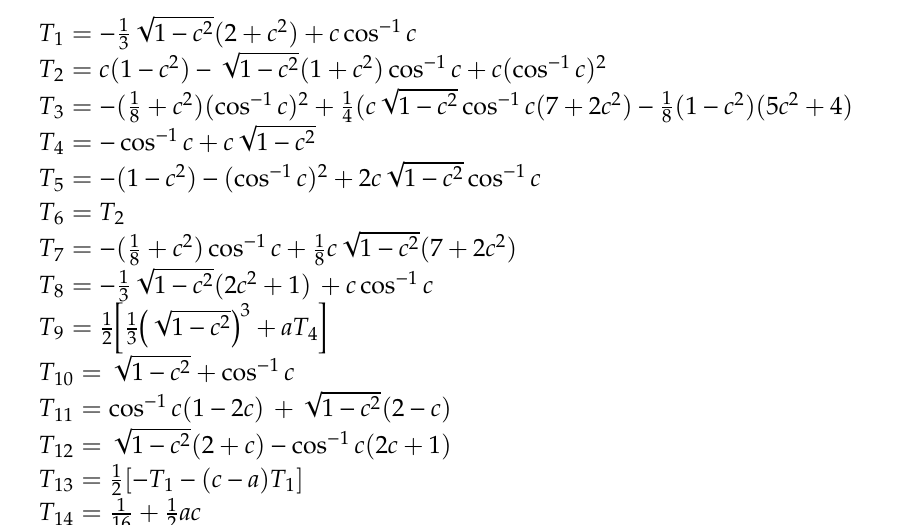
Figure 1. The origin of coordinate system XYZ located at elastic axis. The constants T 1 to T 14 that are used in Equations (10)–(12) are as